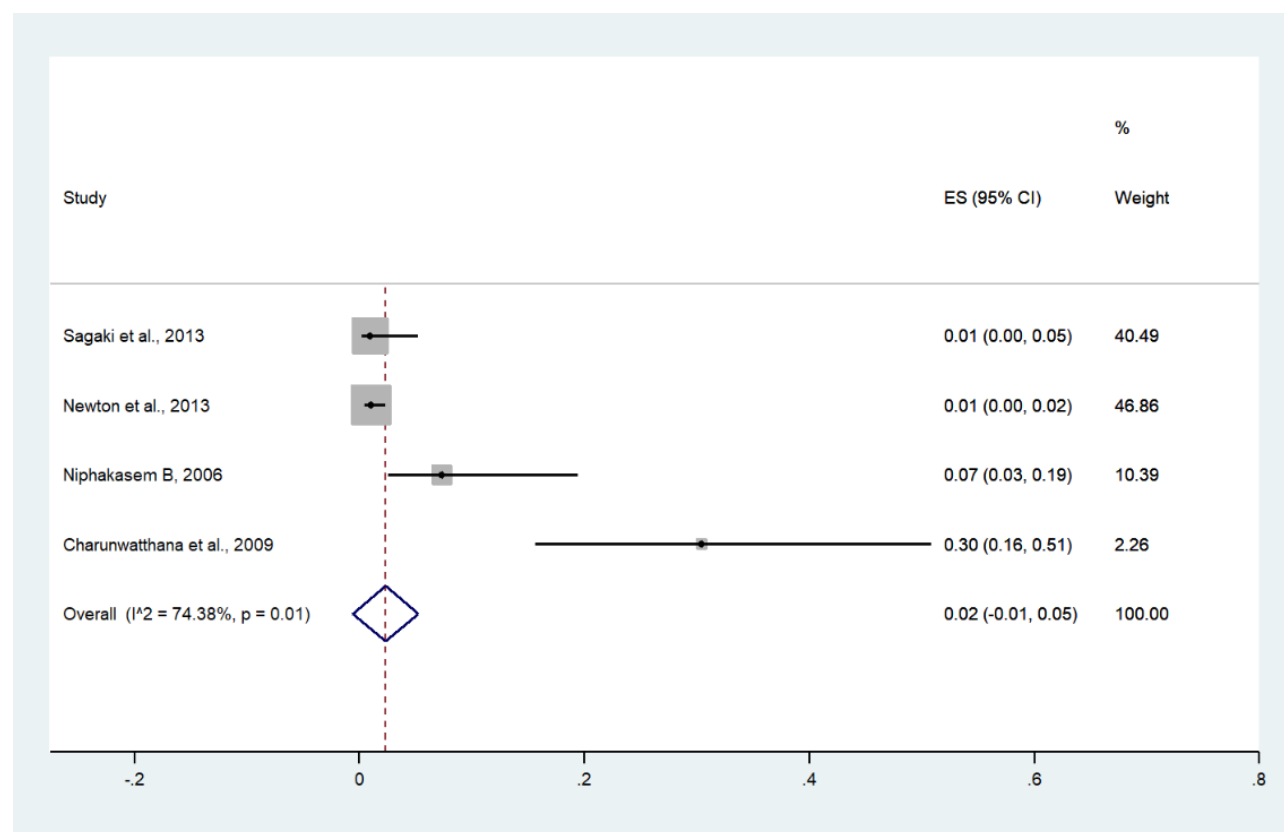
Figure 16. The pooled prevalence of bleeding/DIC among patients with severe malaria in Thailand. The label for the x-axis is the scale of estimated prevalence. Abbreviations; ES, estimated prevalence; CI, confidence interval. Table 3. The estimated proportion of signs of severity per all signs of severity in Thailand (total signs of severity = 4324).